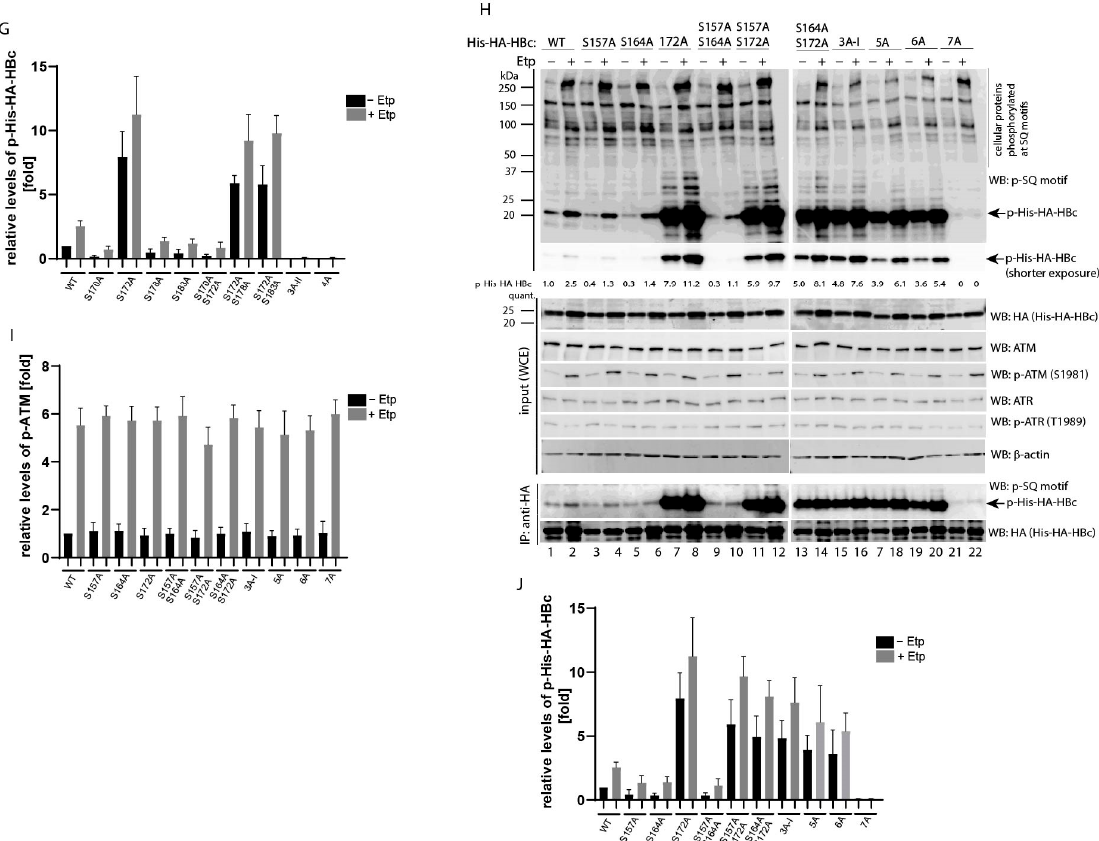
Figure 3. Analysis of etoposide-induced phosphorylation of HBc S-to-A mutants. ( A ) Schematic representation of serine- to-alanine mutations in the C-terminal domain of HBc protein and the experimental outline. The sequence of wild type HBc corresponds to HBV genotype A, subtype adw2. The experimental outline was as follows: HepG2-NTCP cells were transfected with equal amounts of His-HA-HBc wt or S-to-A mutants. Forty-eight hours after transfection, cells were treated with 0.1% DMSO ( − ) or 100 µ M etoposide (+) for 1 h, then washed twice and cultured for an additional 4 h. The isolated whole cell extracts (WCE) were analyzed by Western blot or immunoprecipitation. ( B ) Analysis of serine phosphorylation at SQ motifs of HBc wild type and single S-to-A mutants. The images display the protein lysates (20 µ g) that were analyzed by Western blot (marked as input (WCE)) using antibodies (from the top to the bottom) against a phospho-SQ motif (p-SQ), HA (His-HA-HBc), ATM, p-ATM, ATR, p-ATR and β -actin (used as a loading control). IP:anti-HA represents the cell lysates (800 μ g) that were precipitated (IP) with anti-HA antibodies (His-HA-HBc), and the precipitated complexes were analyzed by Western blot with an anti-p-SQ or anti-HA antibodies. The arrows indicate the expected position of the 24 kDa His-HA-HBc protein (21.5 kDa of HBc plus 2.5 kDa of His-HA tag) that is phosphorylated at the SQ sites (p-His-HA-HBc). The Western blots are representative of three independent transfection experiments. The intensity of the HBc phosphorylation signal (p-His-HA-HBc) was quantified and normalized to the corresponding level of the total His-HA-HBc expression. The level of HBc wt phosphorylation in untreated cells was set to 1. ( C , D ) The statistical analyses of the ATM phosphorylation signal (p-ATM; shown in ( C )) and the HBc phosphorylation signal (p-His-HA-HBc; shown in ( D )) that were determined in ( B ) using Image Studio Lite Software for densitometric analysis. The data are shown as mean ± SD from three independent experiments. The asterisks indicate statistically significant differences between HBc wt and HBc mutant groups determined by a two-tailed paired t test, * p < 0.05, ** p < 0.01, **** p < 0.0001, n = 3. ( E ) Analysis of serine phosphorylation at SQ motifs of HBc wild type and single or multiple S-to-A mutants as indicated. The Western blot analyses of whole cell extracts (input (WCE)), and immunoprecipitation (IP:anti-HA) were analyzed as in ( B ) with the only difference that the p-His-HA-HBc values were calculated as mean of two independent experiments. ( F , G ) The den- sitometric analyses of the ATM phosphorylation signal (p-ATM; shown in ( F )) and the HBc phosphorylation signal (p- His-HA-HBc; shown in ( G )) that were determined in ( E ) using Image Studio Lite Software. The data are shown as mean ± SD from two independent experiments. ( H ) Analysis of serine phosphorylation at SQ motifs of HBc wild type and single or multiple S-to-A mutants. The Western blot analyses of whole cell extracts (input (WCE)), and immunoprecipitation (IP:anti-HA) were analyzed as in ( B ) with the only difference that the p-His-HA-HBc values were calculated as mean of two independent experiments. ( I , J ) The densitometric analyses of the ATM phosphorylation signal (p-ATM; shown in (I)) and the HBc phosphorylation signal (p-His-HA-HBc; shown in ( J )) that were determined in ( H ) using Image Studio Lite Software. The data are shown as mean ± SD from two independent experiments.